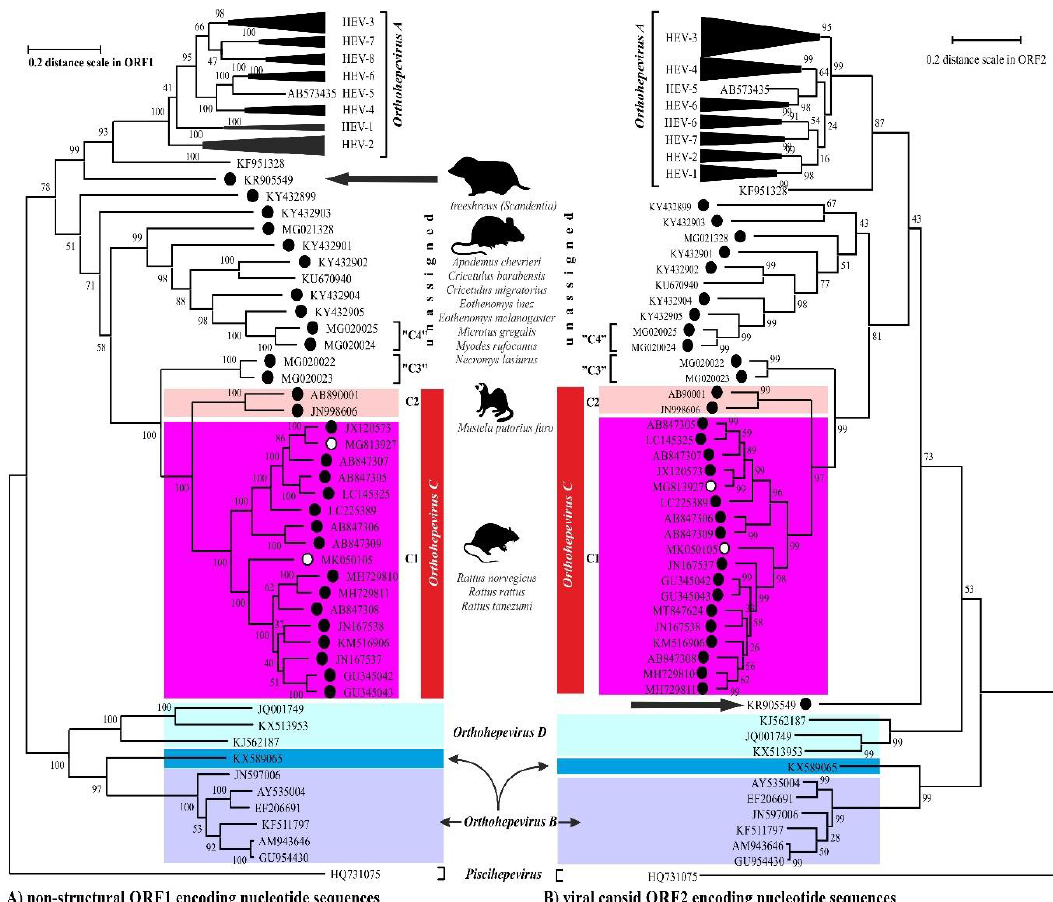
Figure 3. The phylogenetic reconstruction of hepeviruses. Phylogenetic trees are generated based on the ( A ) ORF1-encoded non-structural polyprotein (left) and ( B ) ORF2-encoded capsid protein (right) sequences and each tree are rooted to piscihepevirus A ( Piscihepevirus ) srain Heenan88 (HQ731075). Each phylogenetic tree is focusing on the analysis of the rodent origin HEV-C1 (magenta), HEV-C2 (pink) sequences in Orthohepevirus C (red) complementing with the currently unassigned rodent-borne hepevirus sequences. The putative HEV-“C3” and HEV-“C4” clades in Orthohepevirus C are also highlighted. The rodent hepeviruses are marked with black dot, while rodent origin HEV-C1 in human infections are highlighted by white dot. The reported (potential) source of infection of hepeviruses are shown next to the lineages. The phylogenetic subtrees are compressed based representative genotypes in Orthohepevirus A. The following sequences are used in subtree HEV-1: AY230202, MH918640, AY204877, X98292, L08816, D11092, LC225387, M73218, JF443721, FJ457024; HEV-2: MH809516, KX578717; HEV-3: